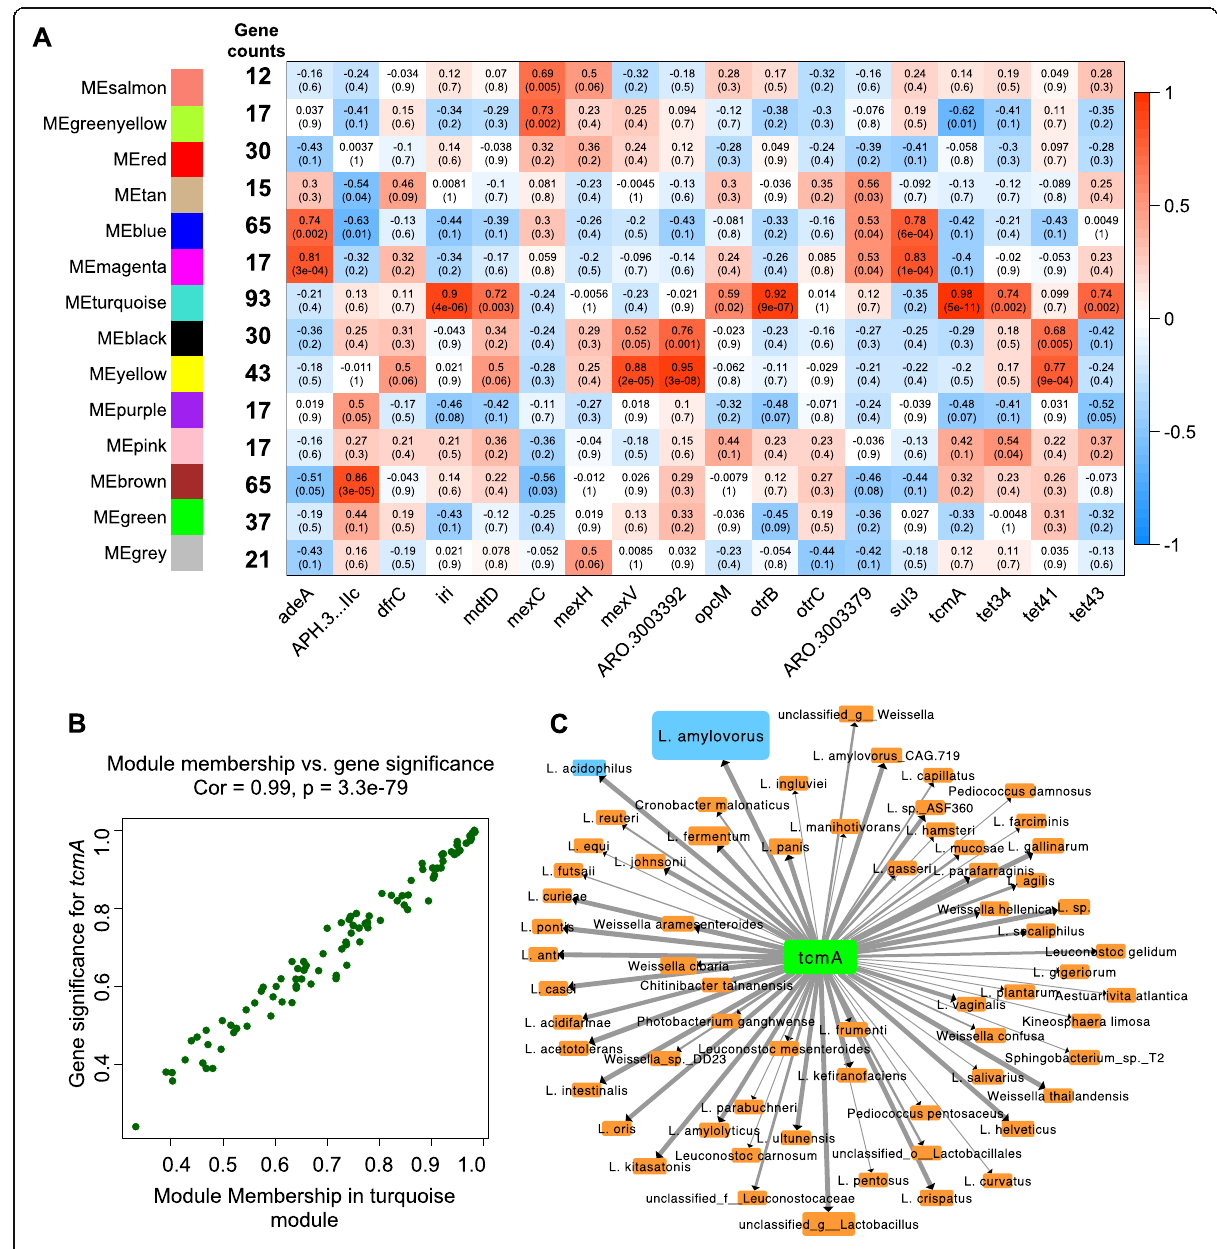
Fig. 5 The relationship between unique ARGs and bacterial species in the rumen of dairy buffaloes. A The relationship between 18 unique ARGs and co-expressed ARGs in the rumen of dairy buffaloes. B The relationship between members in significantly correlated gene module and gene significance for tcmA . C The co-occurrence network of tcmA and its highly associated bacteria species in the rumen of dairy